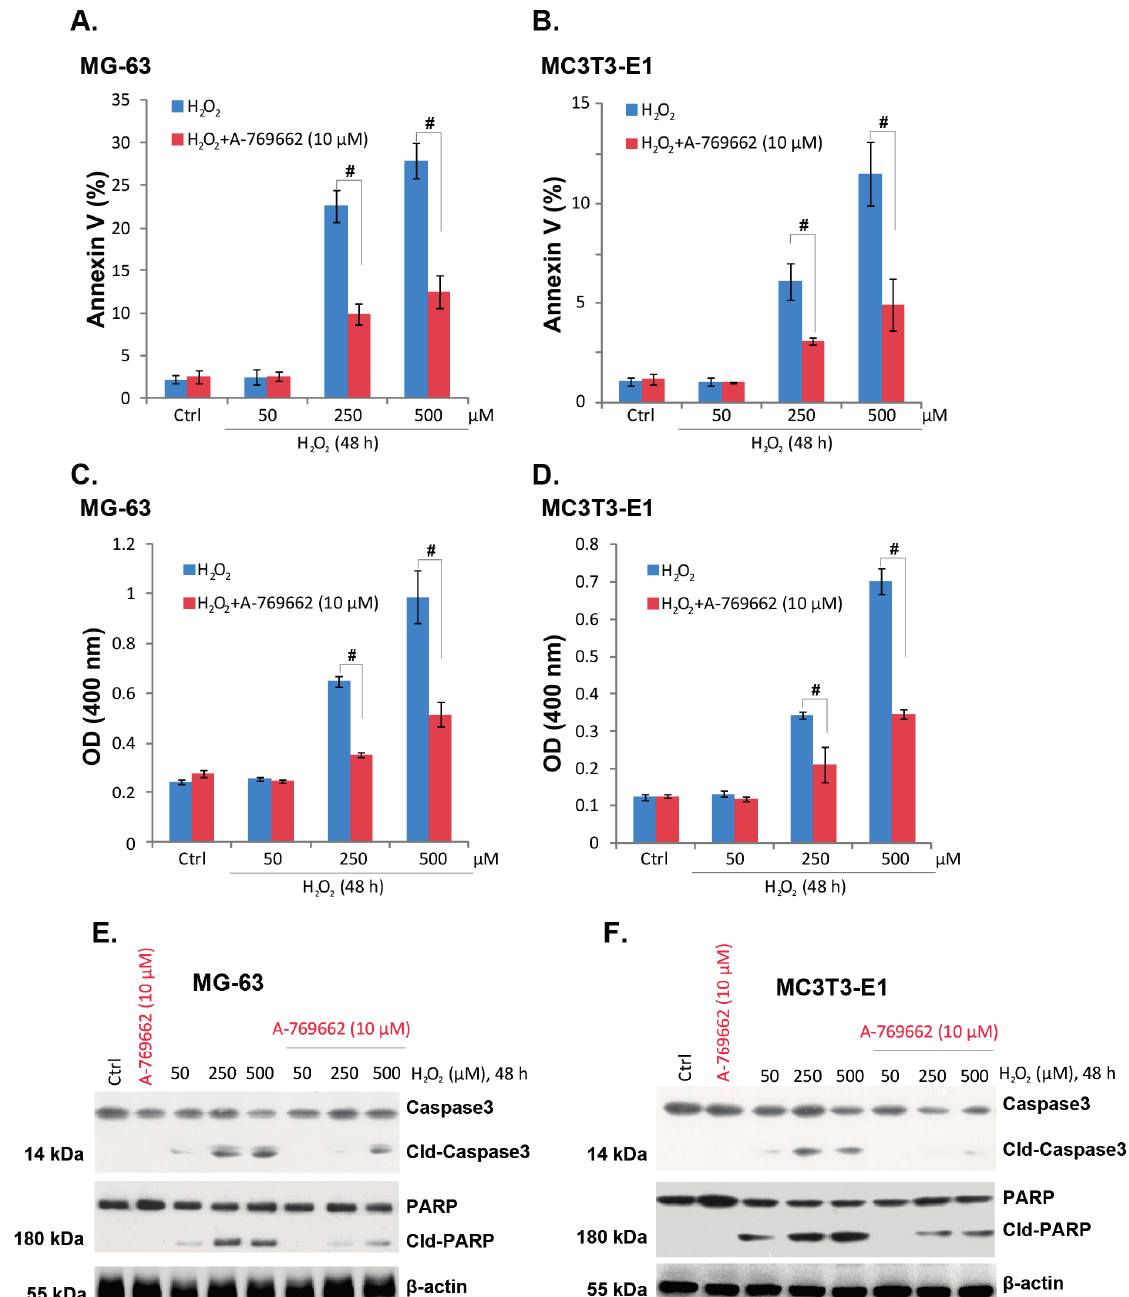
Figure 2. A-769662 suppresses H O -induced osteoblast cell apoptosis. MG-63 and 2 2 MC3T3-E1 cells were pre-treated with A-769662 (10 μ M) for 1 h, followed by hydrogen peroxide (H O , 50–500 μ M) stimulation, cells were further cultured for 48 h, and Annexin 2 2 V fluorescence-activated cell sorting (FACS) assay ( A ) and ( B ) and histone-DNA ELISA assay ( C ) and ( D ) were performed to test cell apoptosis; the expressions of PARP (cleaved and regular), caspase-3 (cleaved and regular) and β -actin were tested by western blots ( E ) and ( F ). # p <